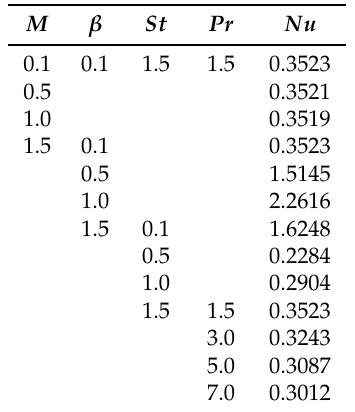
Table 3. For dissimilar values of Pr , M , Rd and St variations in Nu (Nusselt Number).